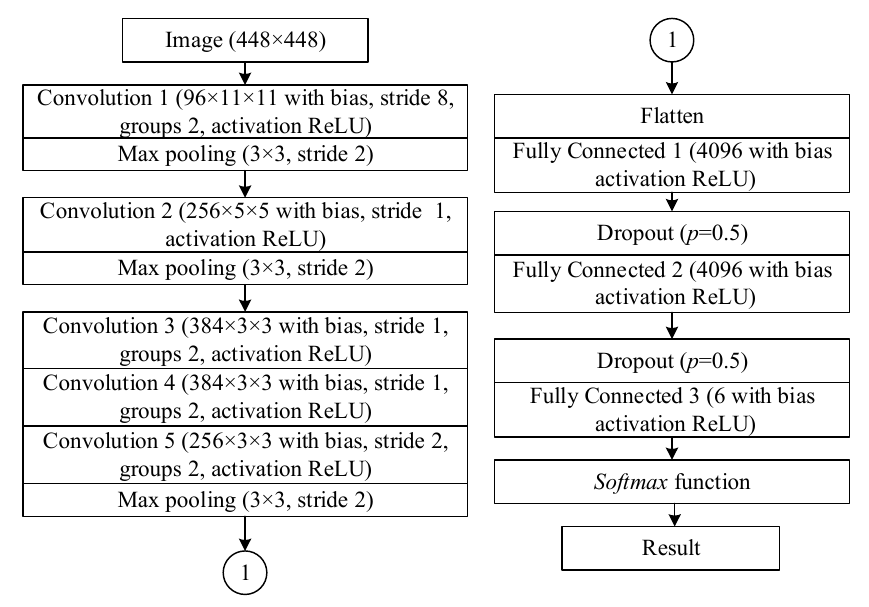
Figure 1. Deep neural network (DNN) model for road type and conditions classification.